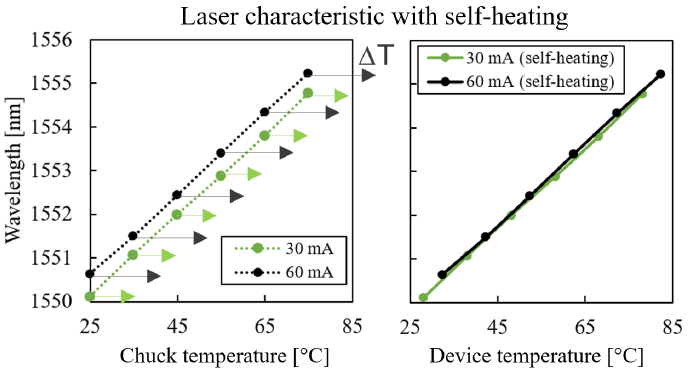
Figure 11. Laser wavelength as a function of ( left ) chuck temperature and ( right ) actual mesa temperature.